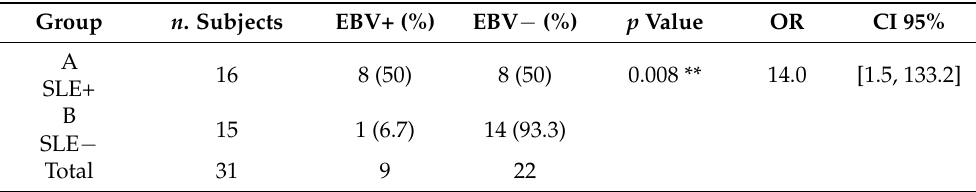
Table 1. Epstein–Barr virus (EBV) detection by qPCR in salivary swabs from patients with systemic lupus erythematosus (SLE+) and control subjects (SLE − ).